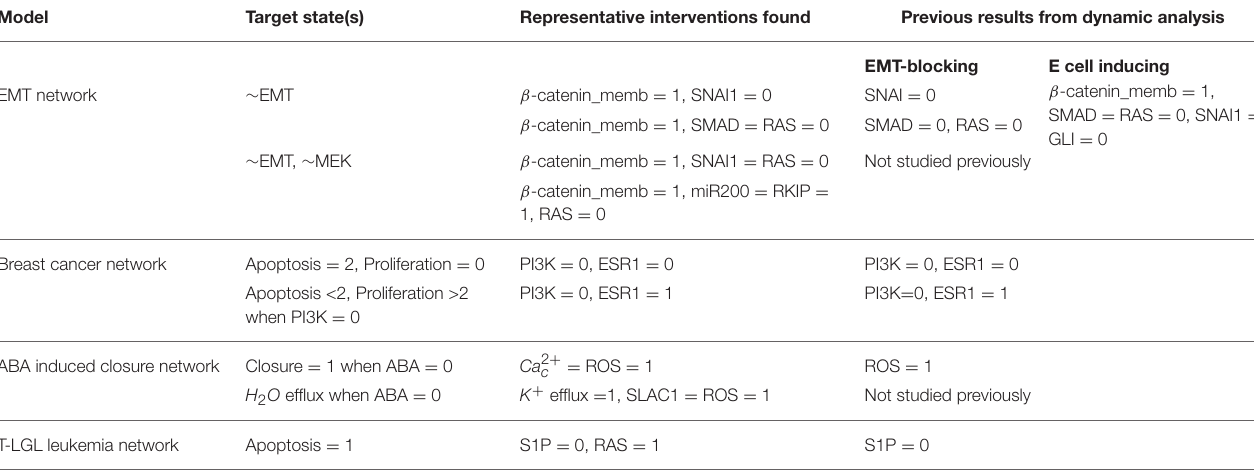
TABLE 2 | Summary of representative target control solutions found by our algorithm for four biological network models.